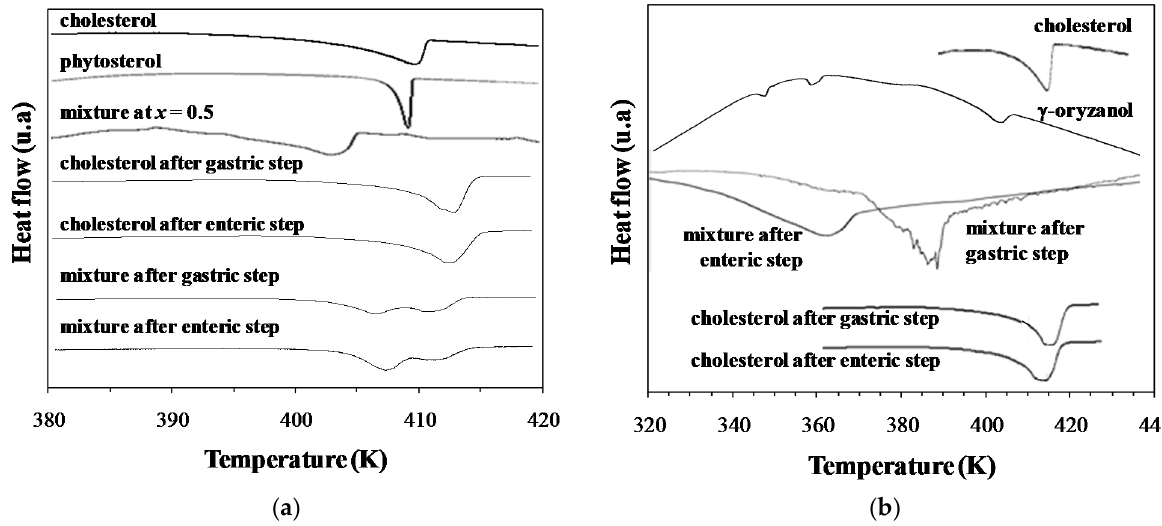
Figure 6. DSC thermograms for cholesterol and their mixture with ( a ) phytosterol and ( b ) γ -oryzanol before and after digestion.